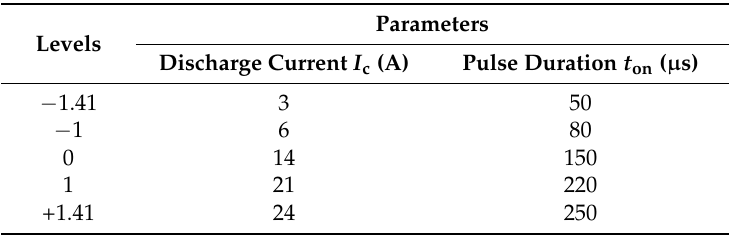
Table 1. Design scheme of process parameters and their